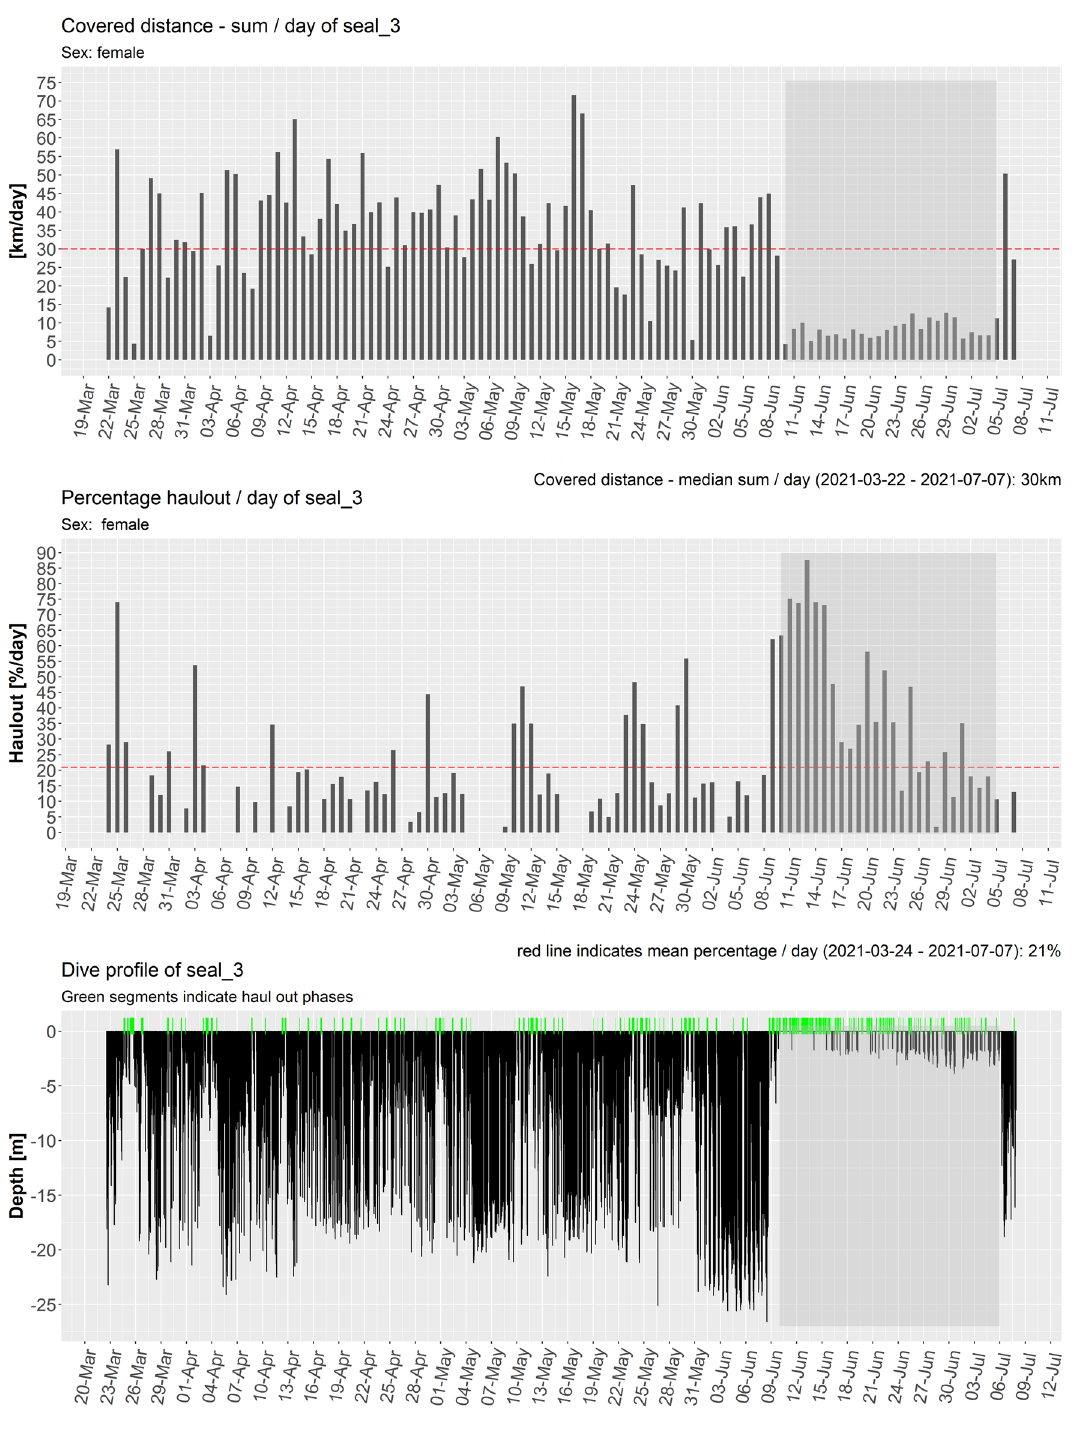
Figure 9. Bar plots showing the covered distance per day (top), the proportion of the day spent in haul out (middle) and the dive depth reached as well as haul out as green bars (bottom) for the female seal_3 as one example. Areas shaded in darker grey indicate the period of behavioural change indicative for the reproductive